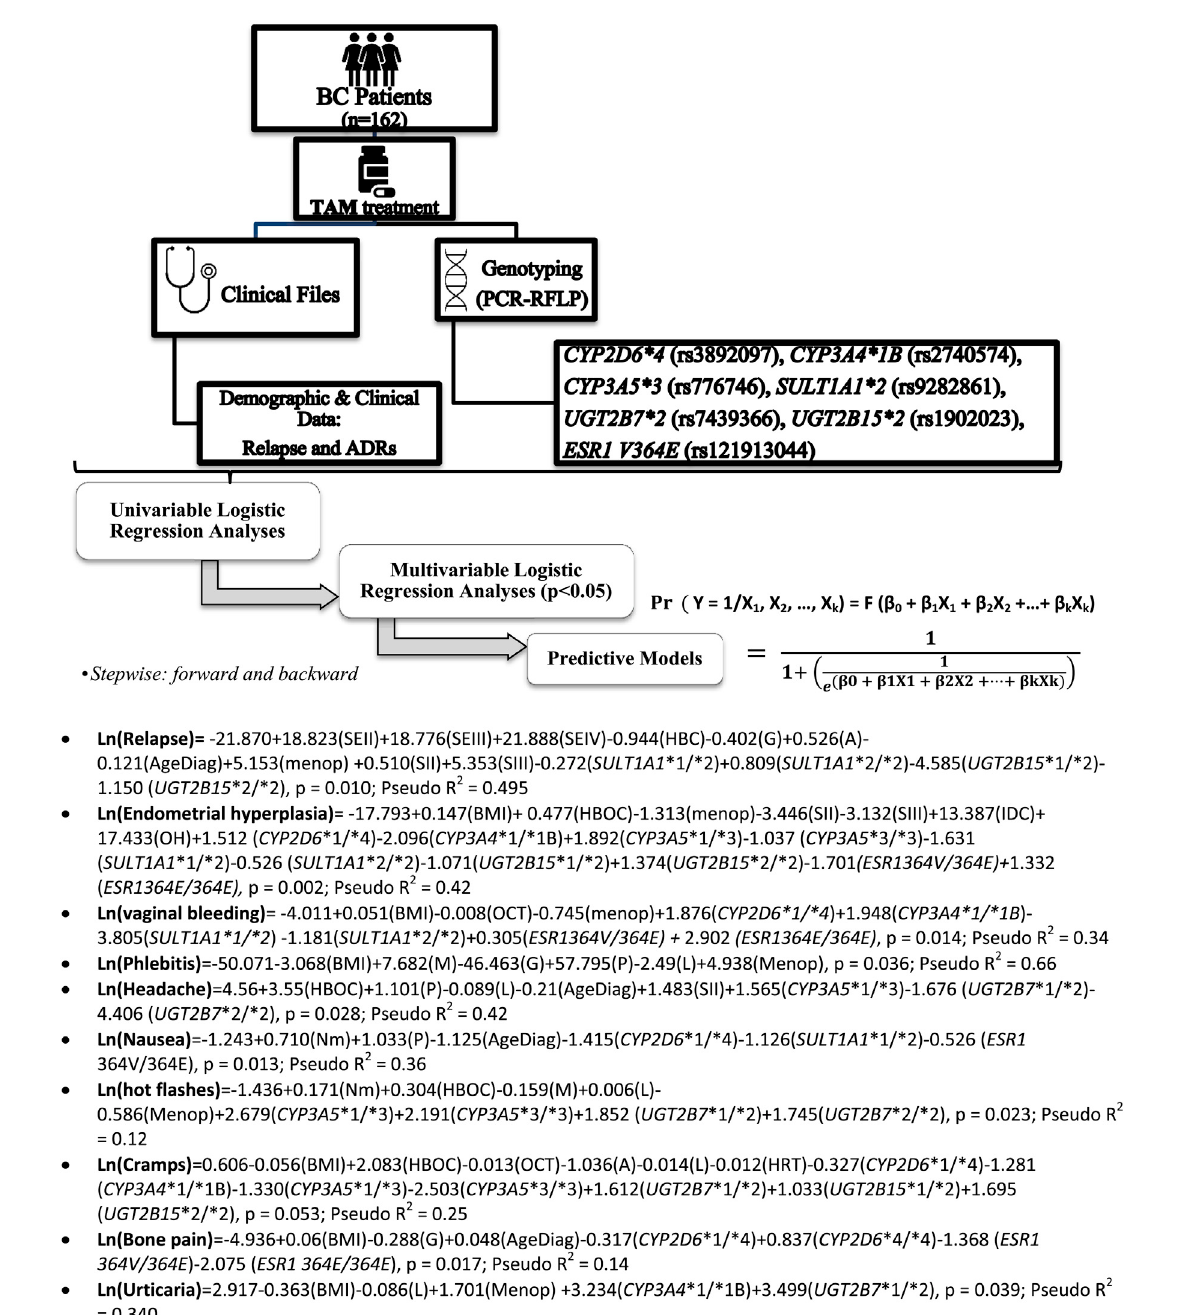
FIGURE 1 | Research Scheme and obtained multivariate predictive models. ADRs, adverse drug reactions; BC: Breast Cancer; SULT: Sulfotransferase; UGT: UDP- glucuronosyl transferase; CYP: Cytochrome P-450; ESRA: Estrogen Receptor 1; SE: Socioeconomic status (per capita income), I: < $135.000 CLP (U$ 200); II: $135.001- $500.000 CLP (U$ 200 – 750); III:$500.001-$1.000.000 CLP (U$ > 750 – 1,450); IV: > 2.000.000 CLP > $CLP 2,000,000 (U$ > 2,900); HBC: Family History ofBreast Cancer; HBOC: Family History ofbreastorovary cancer; M: Menarche age;G:NumberofGestations; A: Number ofAbortions; P:Number ofdeliveries; L: Breastfeeding time; Age diag: Age of diagnosis, years; OCT: Oral Contraceptive Treatment; HRT: Treatment with HRT for menopause; Menop: postmenopause; S: Cancer stage at diagnosis (Stage I-IV); DCis: Ductal carcinoma in situ; IDC: Invasive Ductal Carcinoma; ILC: Invasive Lobular Carcinoma; OH: Others Histology (OH) .